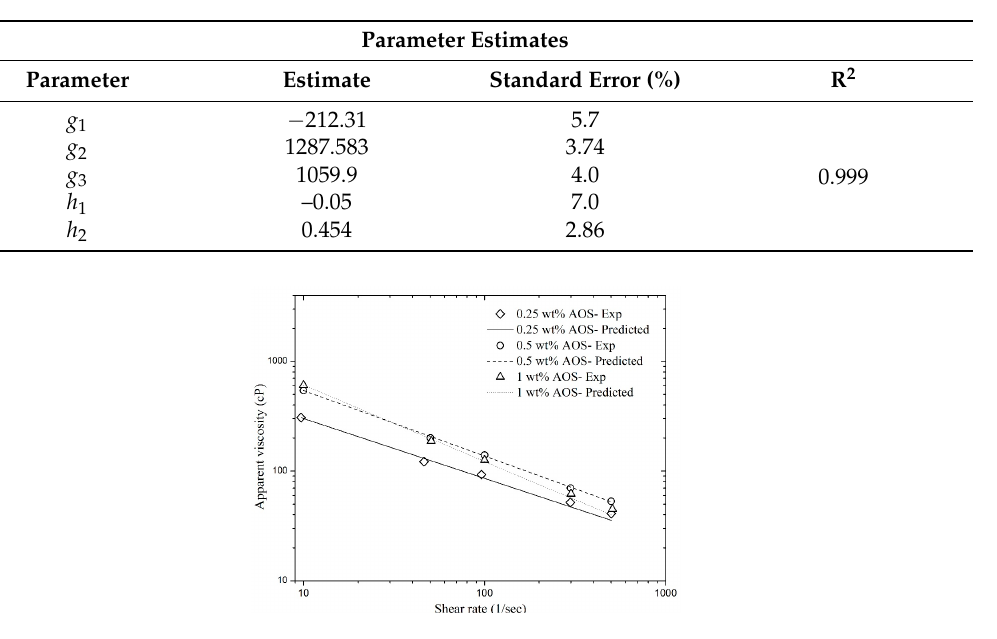
Figure 5. Matches between the experimental data and the predicted values (using Equation (6)) of CO 2 foam apparent viscosity as a function of shear rate and AOS concentration.